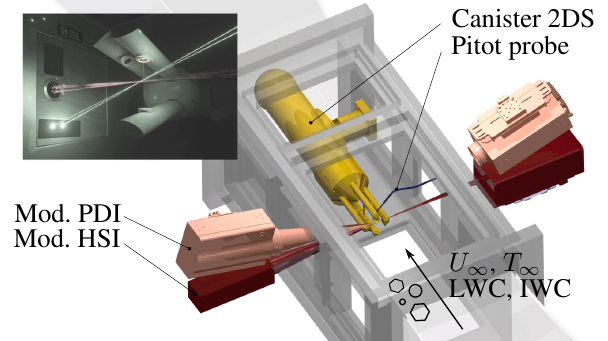
Figure 26. Setup of the probe inter-comparison exercise. Alterna- tively to the canister 2D-S probe, which is shown here, the canister HSI probe was mounted. Upper left: C-HSI probe mounted inside the icing wind tunnel, modular PDI and HSI laser beams are ad- justed close to the C-HSI sampling volume.